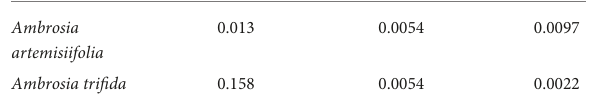
TABLE 2 Moran’s I test results of the spatial autocorrelation of the generalized linear model (GLM)